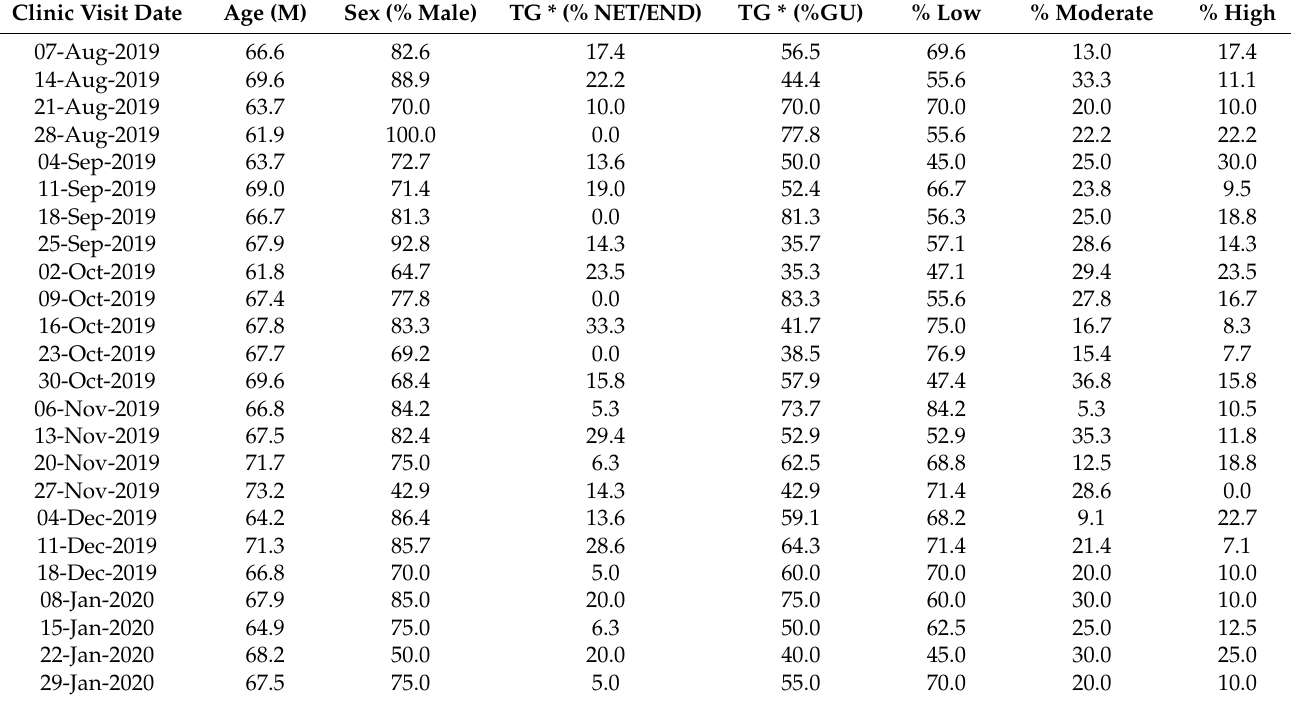
the green line. The forecasted percentage of high symptom complexity levels ranged from 7.3% to 26.7%. Table 2. Patient characteristics and distribution of symptom complexity at the clinic level.